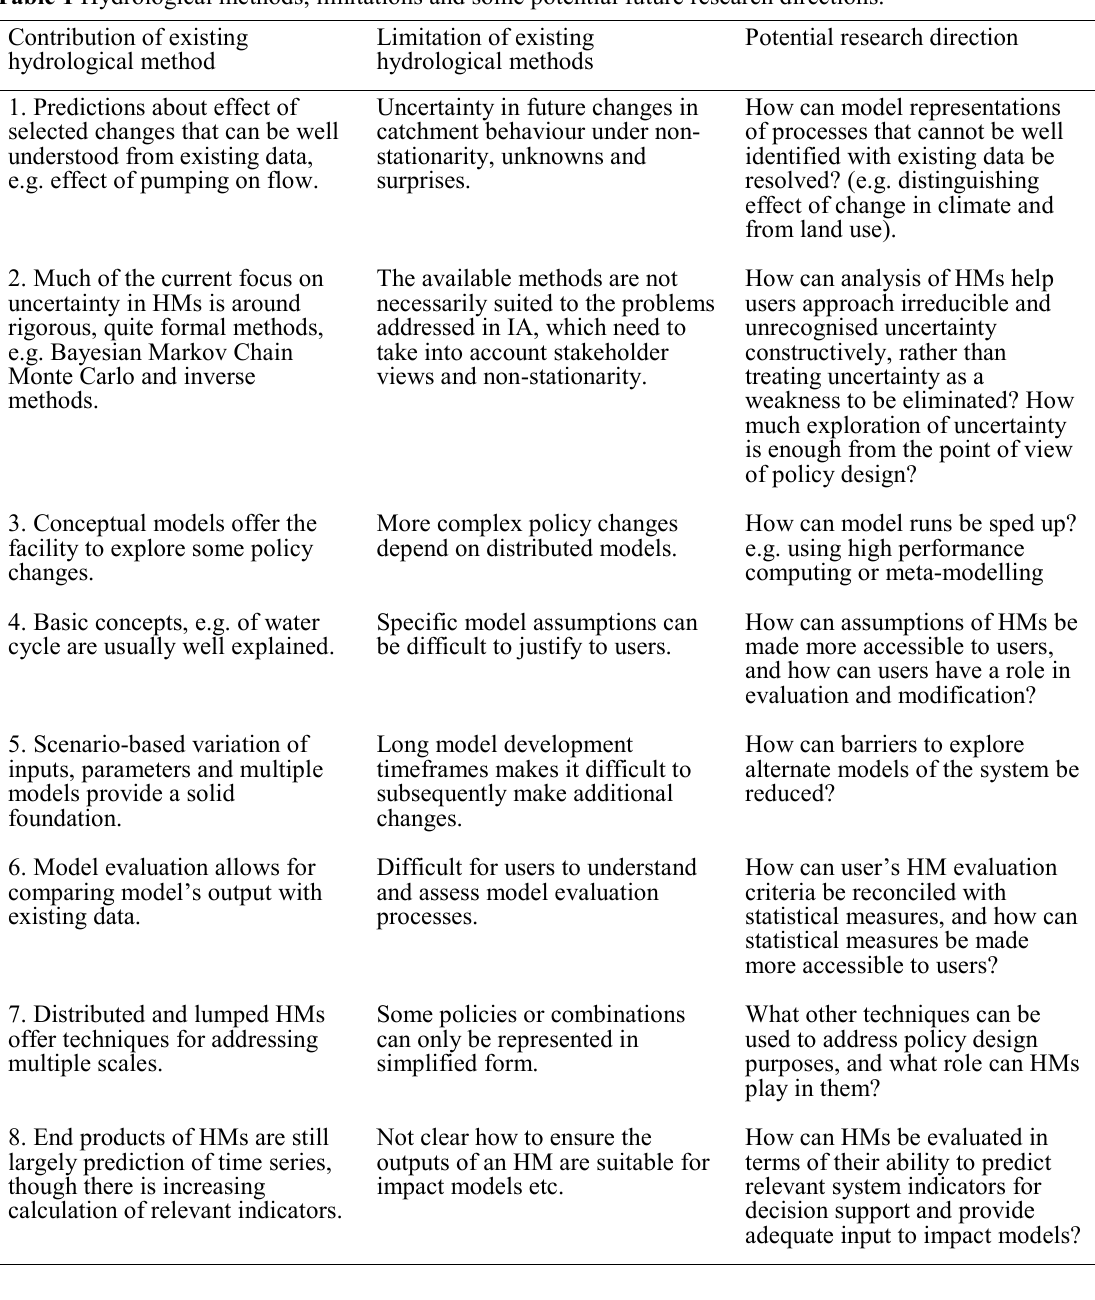
Table 1 Hydrological methods, limitations and some potential future research